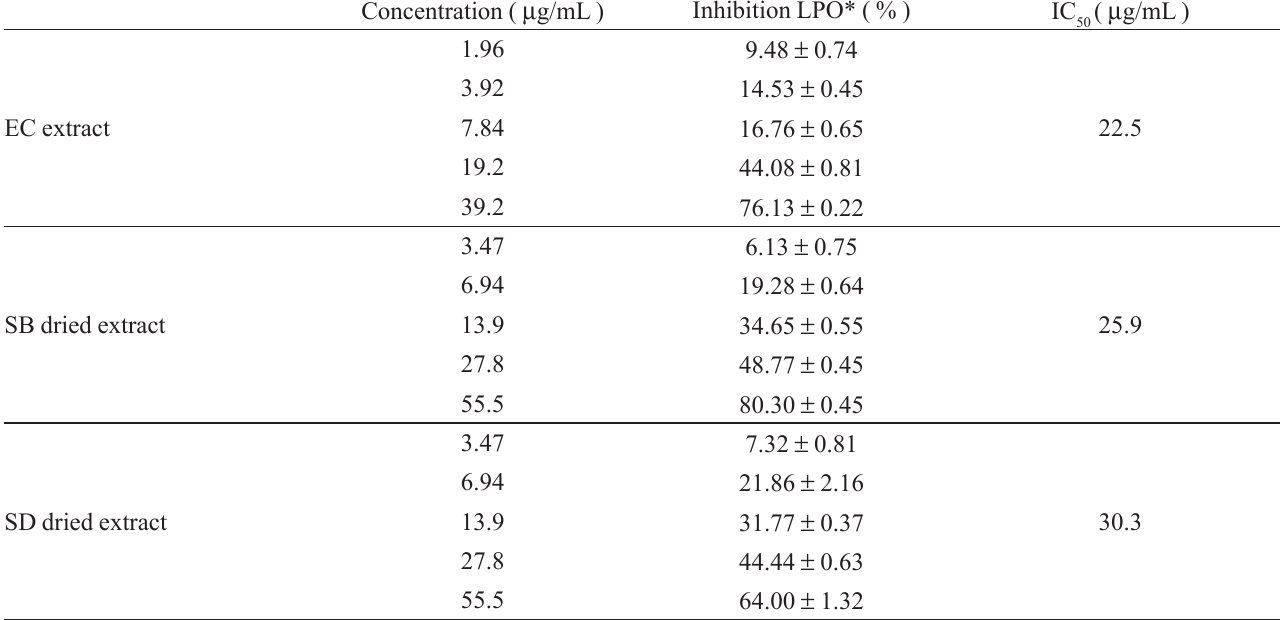
TABLE V - Antiradical activity of Bauhinia forficata extracts observed with lipidic peroxidation assays (LPO) Concentration ( m g/mL ) Inhibition LPO* ( %